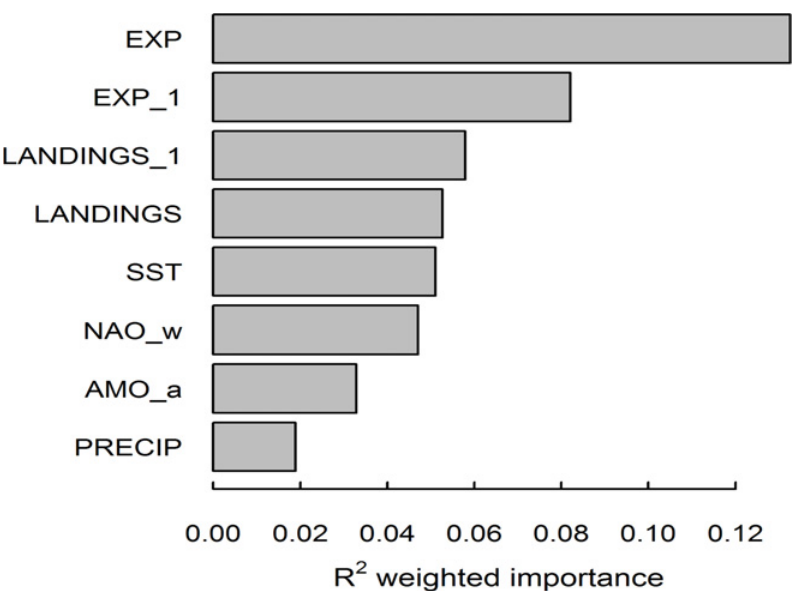
Fig 1. Importance of environmental and anthropogenic pressure variables weighted across ecological indicator outputs R 2 sp . EXP, exploitation; EXP_1, 1-yr lagged exploitation; LANDINGS_1, 1-yr lagged landings (t); LANDINGS, landings (t); SST, sea surface temperature (°C); NAO_w, winter North Atlantic Oscillation Index; AMO_a, mean annual Atlantic multi-decadal oscillation index; PRECIP,